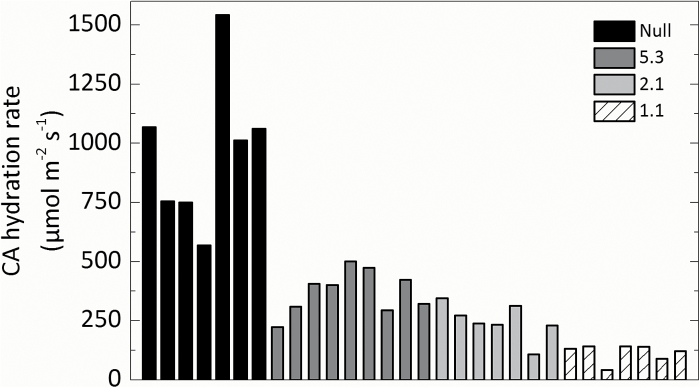
Range of CA hydration rates at mesophyll pCO2 (Cm) measured using a membrane inlet mass spectrometer in the null control and T2 plants from lines 5.3, 2.1, and 1.1.